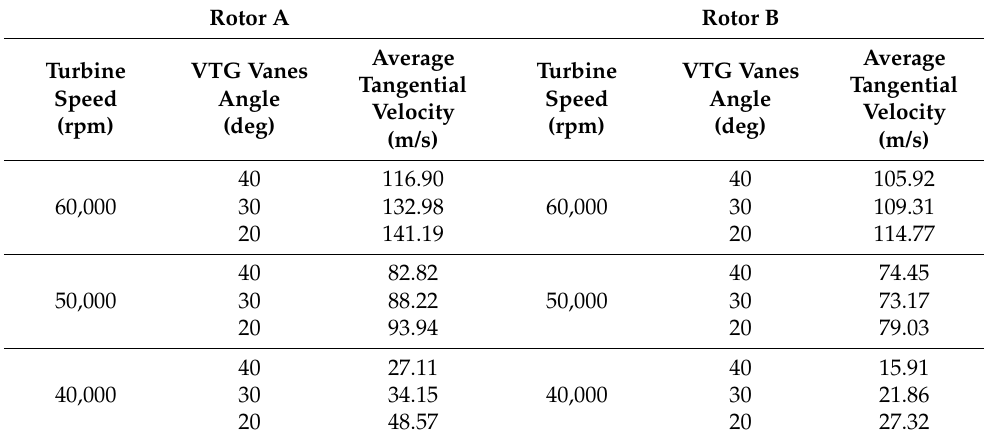
Table 12. The average values of the tangential velocity at the outlet from the first-stage rotor at different turbine speed and VTG vane